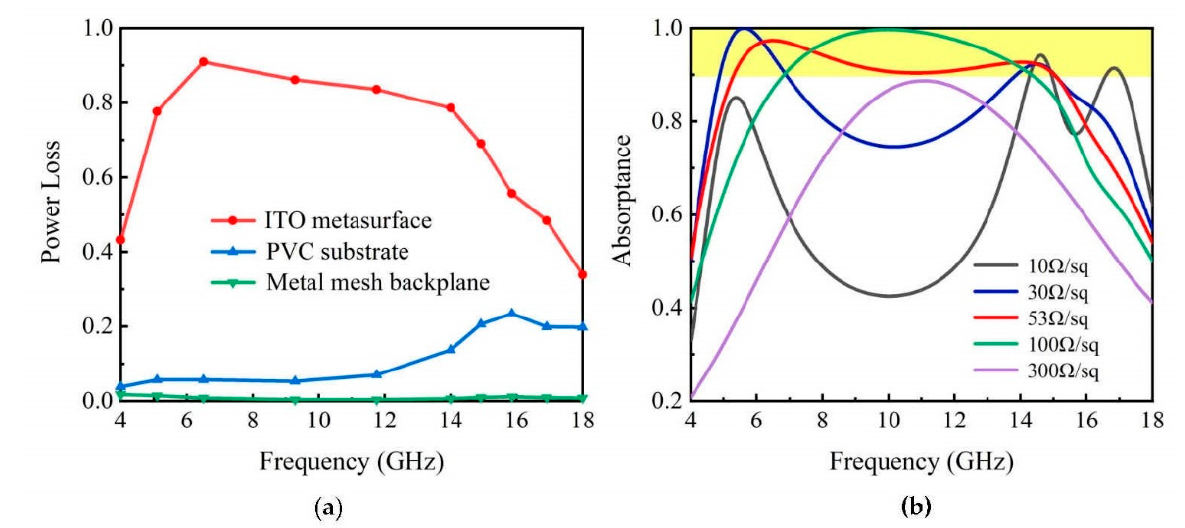
Figure 5. ( a )The simulated power loss of the constitutive components in the FTBMA. ( b ) Simulated absorptance of the proposed structure for various upper-layer surface resistance (R 1 ) values.